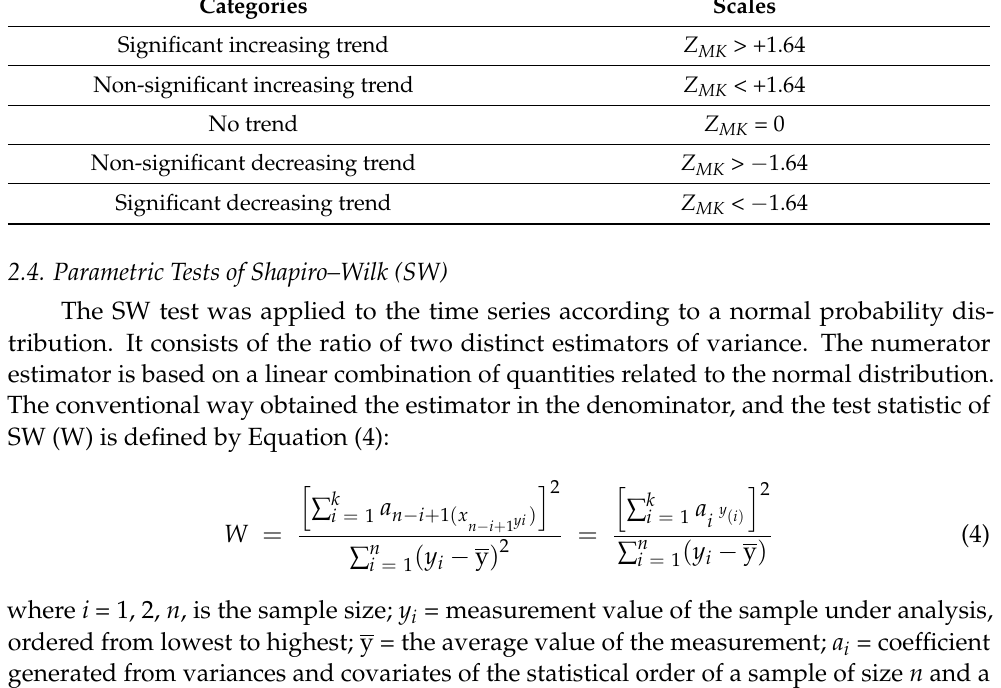
Table 2. Classification of Z MK value in the 90% confidence interval. Categories Scales Significant increasing trend Z MK > +1.64 Non-significant increasing trend Z MK < +1.64 No trend Z MK = 0 Non-significant decreasing trend Z MK > − 1.64 Significant decreasing trend Z MK < −